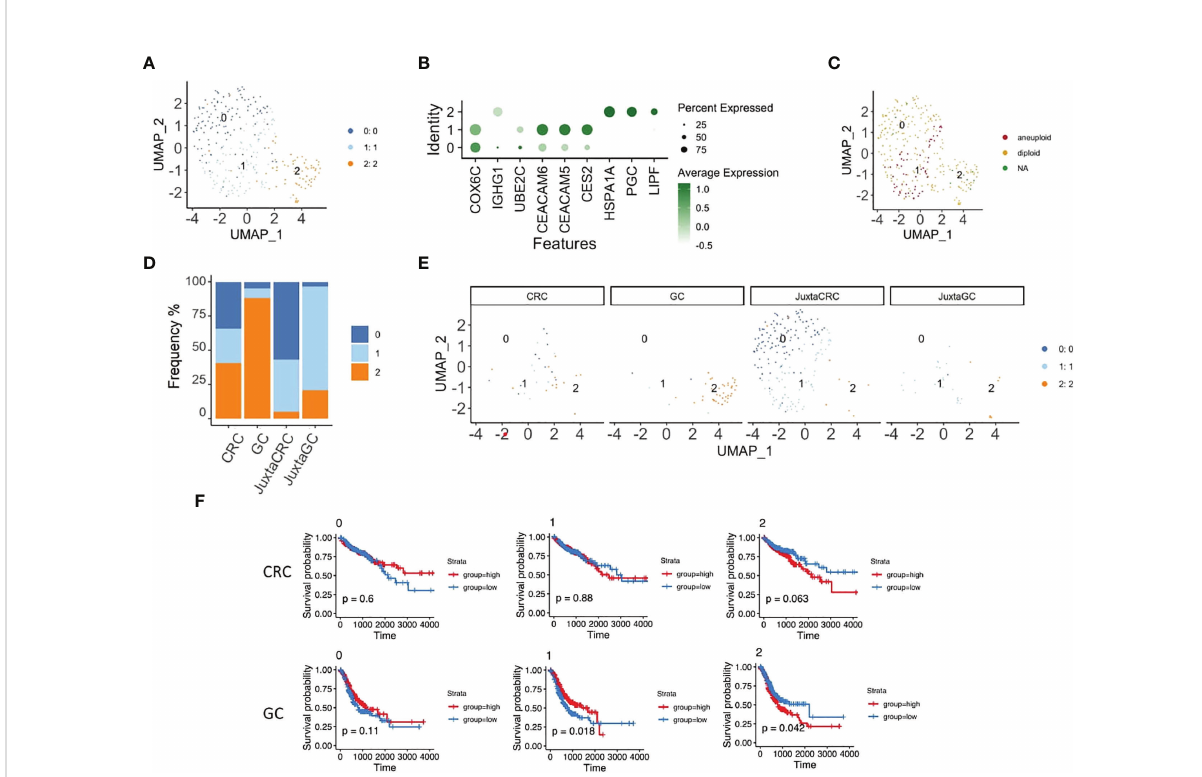
FIGURE 4 Speci fi c epithelial subset enrichment in different TMEs. (A) UMAP plots of the epithelial cell population reveal three cell subsets, namely, clusters 0, 1, and 2. (B) Dot plot shows the top three cluster-speci fi c feature genes, dot size indicates the percent expressed, and the level of color indicates the average expression. (C) UMAP plot of epithelial cell population highlighted by copyKAT results; red refers to aneuploid, yellow refers to diploid, and green refers to NA. (D) Bar plot displays the population of each epithelial cell subset across samples. (E) UMAP plots of epithelial cell population spat by samples. (F) Kaplan – Meier plots show the survival results of the epithelial cell subset GSVA score for CRC and GC based on TCGA database. Red refers to the high group, and blue refers to the low group (top panel: CRC, bottom panel: